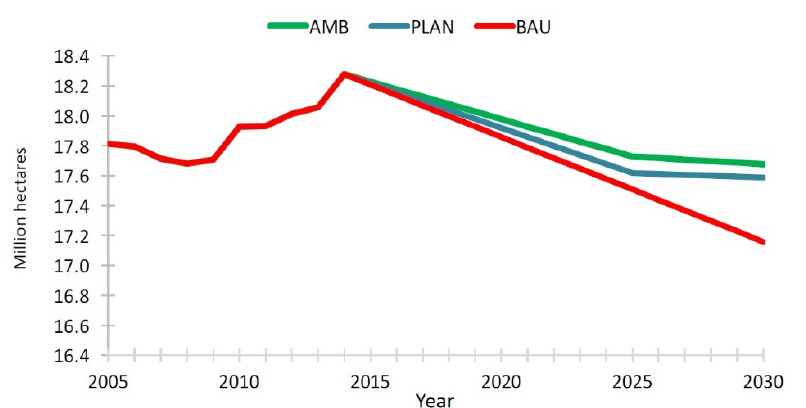
Figure 2. Expected forest cover in Malaysia from 2015 to 2030 under BAU, PLAN and AMB scenarios [12].